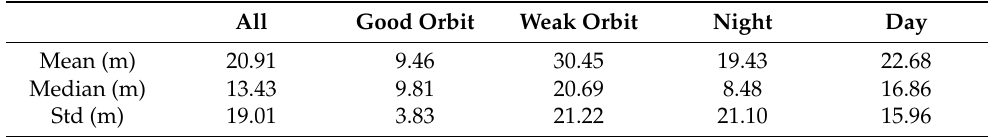
Table 4. The statistical geolocation error